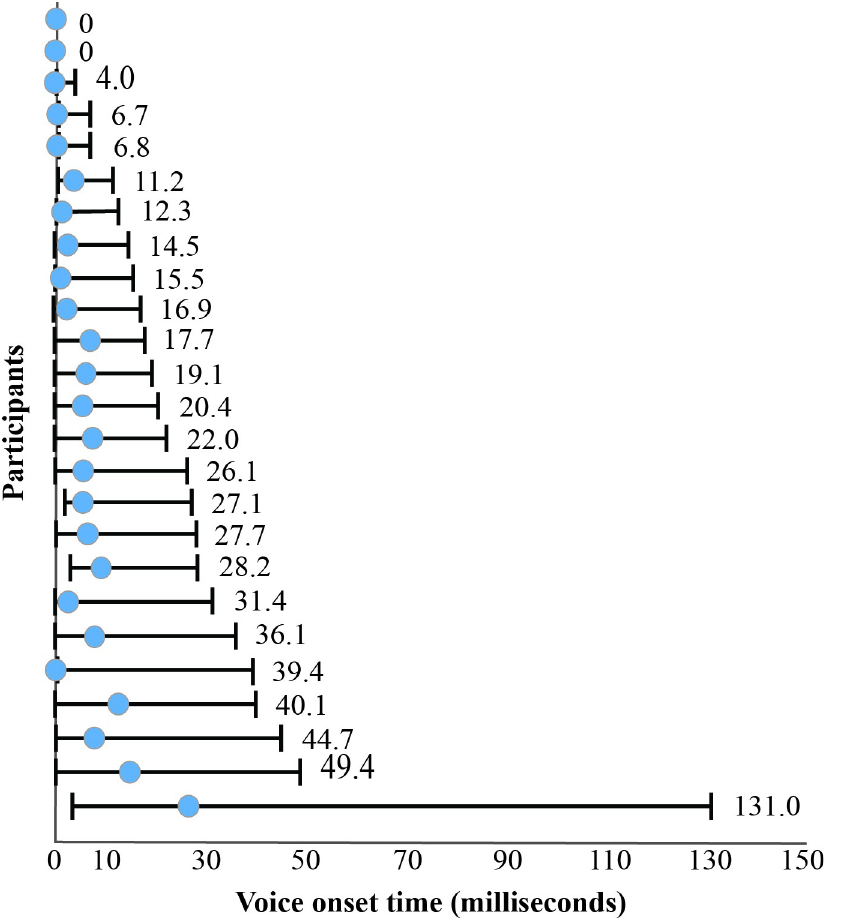
Fig 3. Infant voice onset times. Voice onset time medians (blue dots) and ranges for each infant.